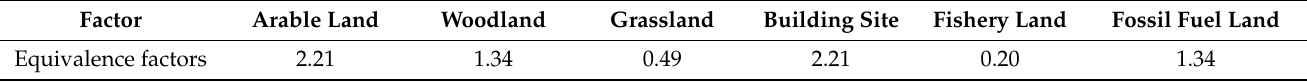
Table 3. Equivalence factors for the six land